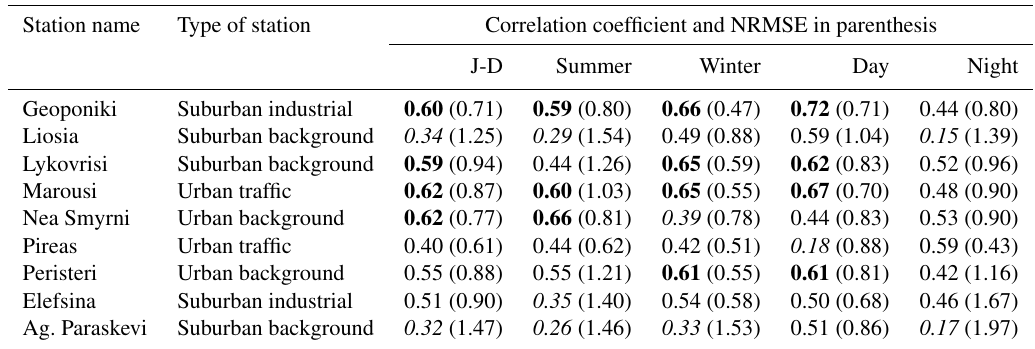
Table 2. As Table 1 but for air quality stations in Athens. All correlation coefficients are statistically significant at the 95%